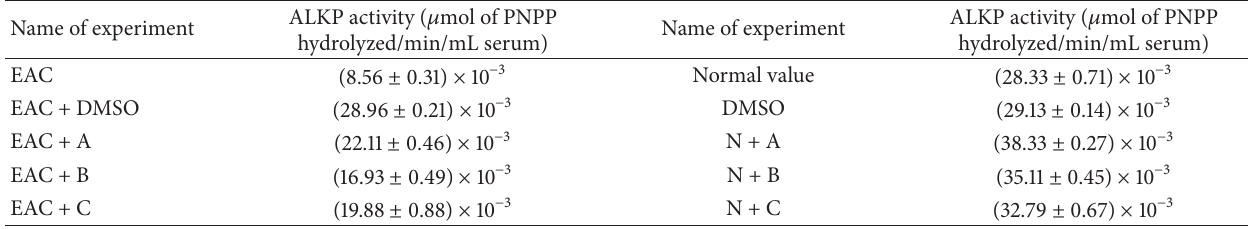
Table 8: The effect of test compounds on serum alkaline phosphatase activity.